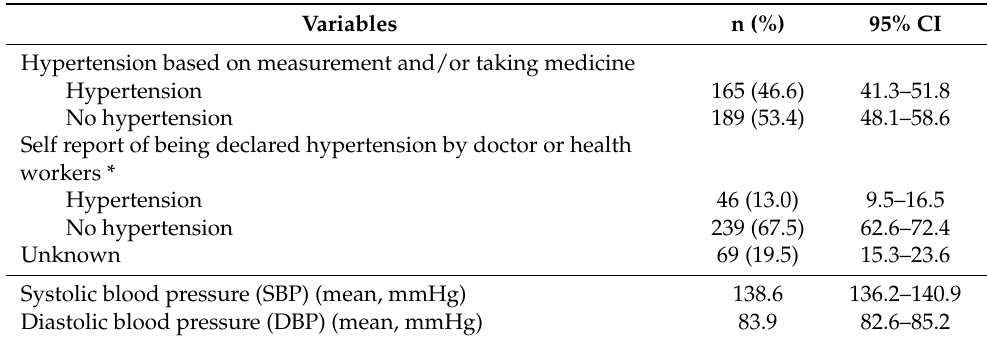
Table 1. Prevalence of hypertension based on blood pressure measurement (average of two measure- ments, 1–2 min apart) and/or self-report of currently taking antihypertension medicine.